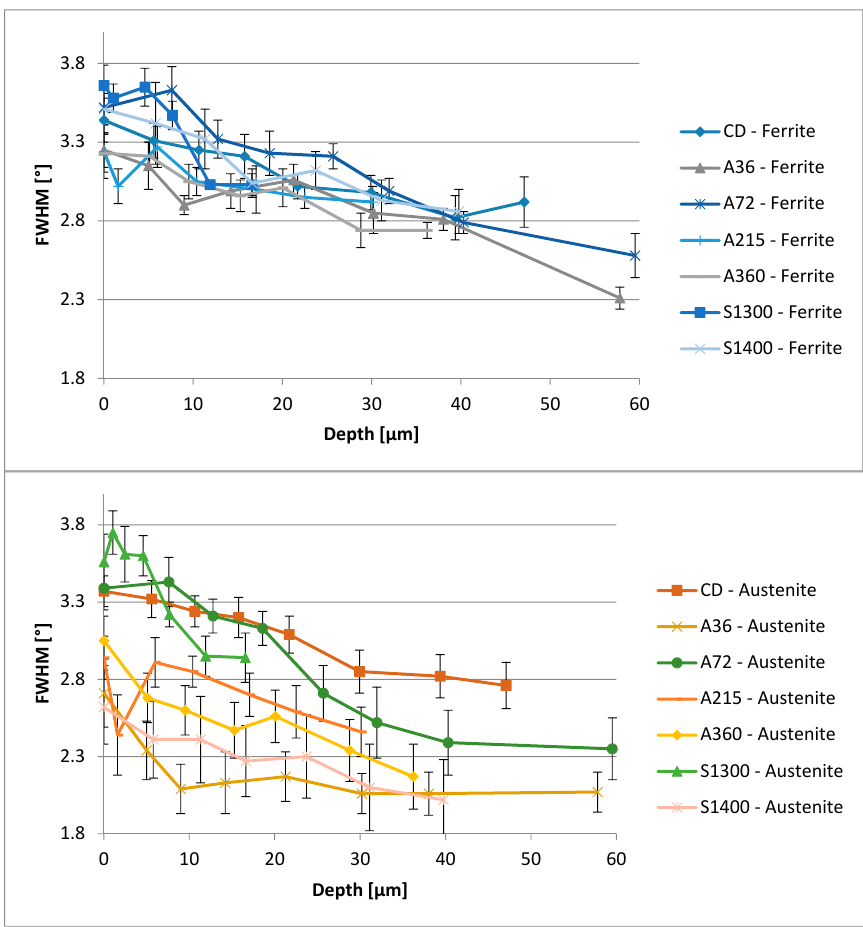
Figure 8. Full Width at Half Maximum (FWHM) parameters obtained via XRD spectra, indicating the presence of crystal lattice imperfections within ferrite ( Above ) and austenite ( Below ).